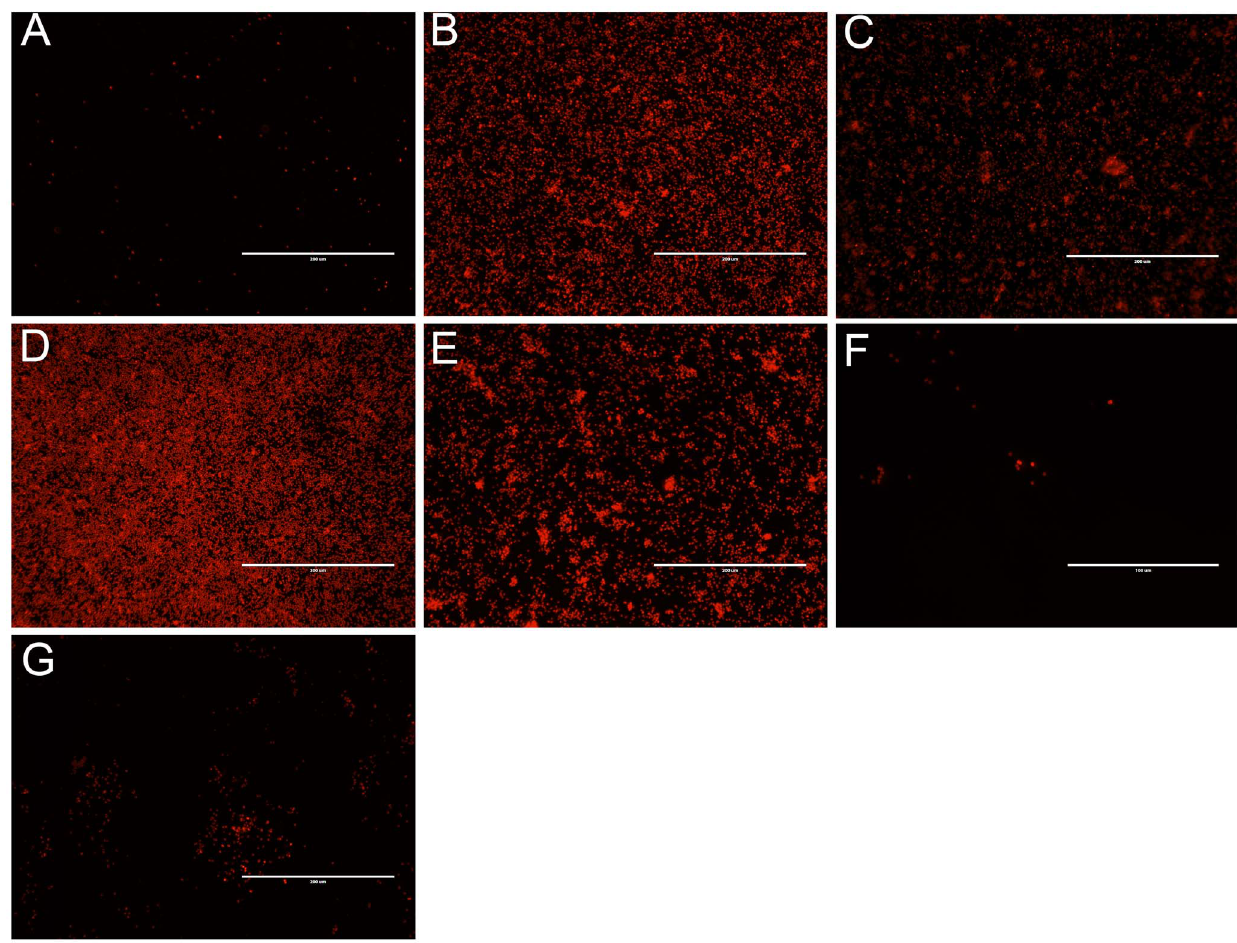
Figure 3. Adherence of mutant strains to glass coverslips after 4 days of growth. Following four days of static growth on sterile glass coverslips, slides were washed gently with water and Synechocystis autofluorescence was visualized by fluorescence microscopy. (A) wild-type, (B)